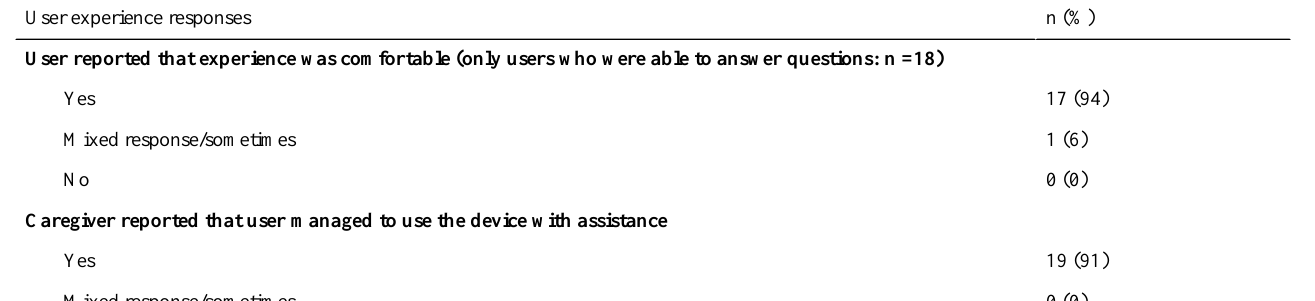
Table 3. User experience report